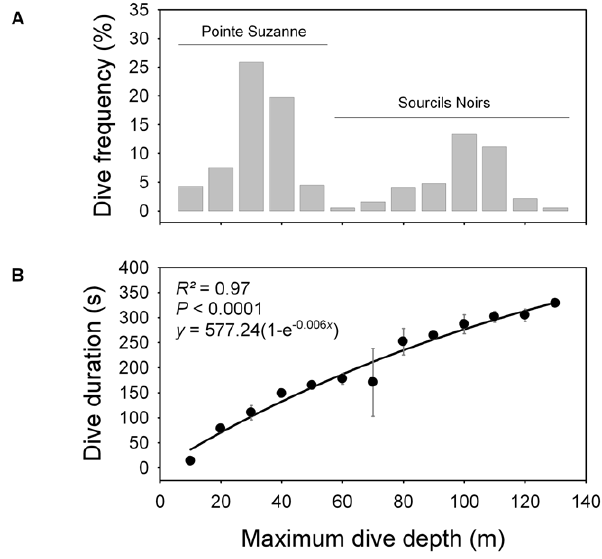
Figure 1. (A) Frequency distribution of maximum dive depths and (B) mean dive duration in relation to dive depth. Shallow dives belong to birds from the Pointe Suzanne colony and deep dives to birds from the Sourcils Noirs colony. Inside each depth class, each dive duration value was calculated as the mean of individual means ( 6